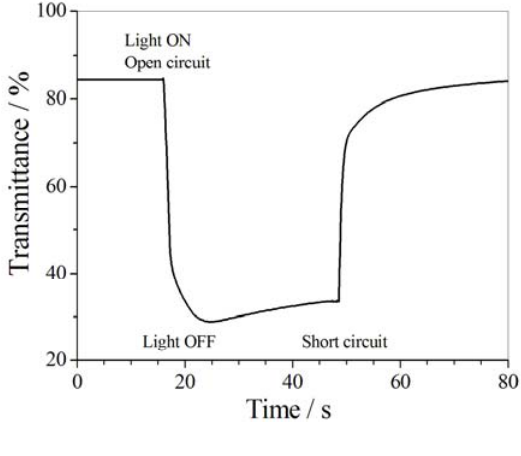
Figure 34. Response of an all-solid photo-electrochromic device.